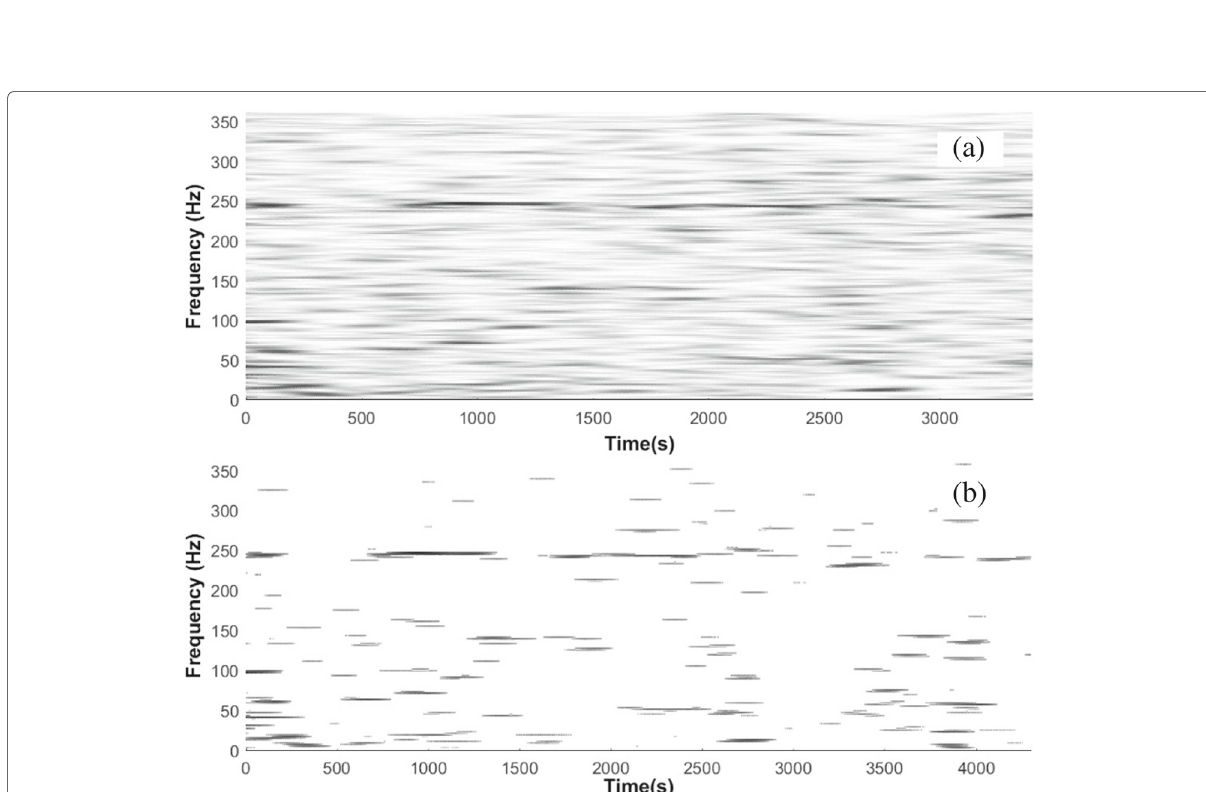
Fig. 5 a Measured faulty electrode spectrogram and b spectrogram after applied K-means